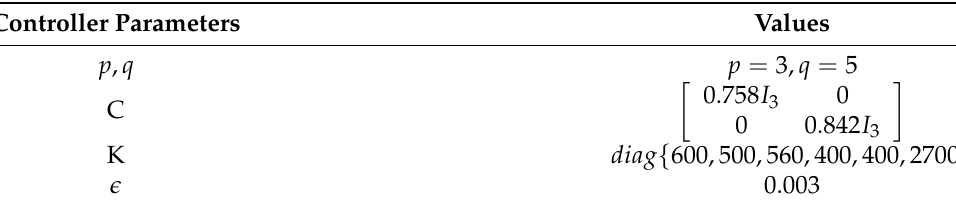
Table 4. The controller parameters for TSMC on SE(3). Controller